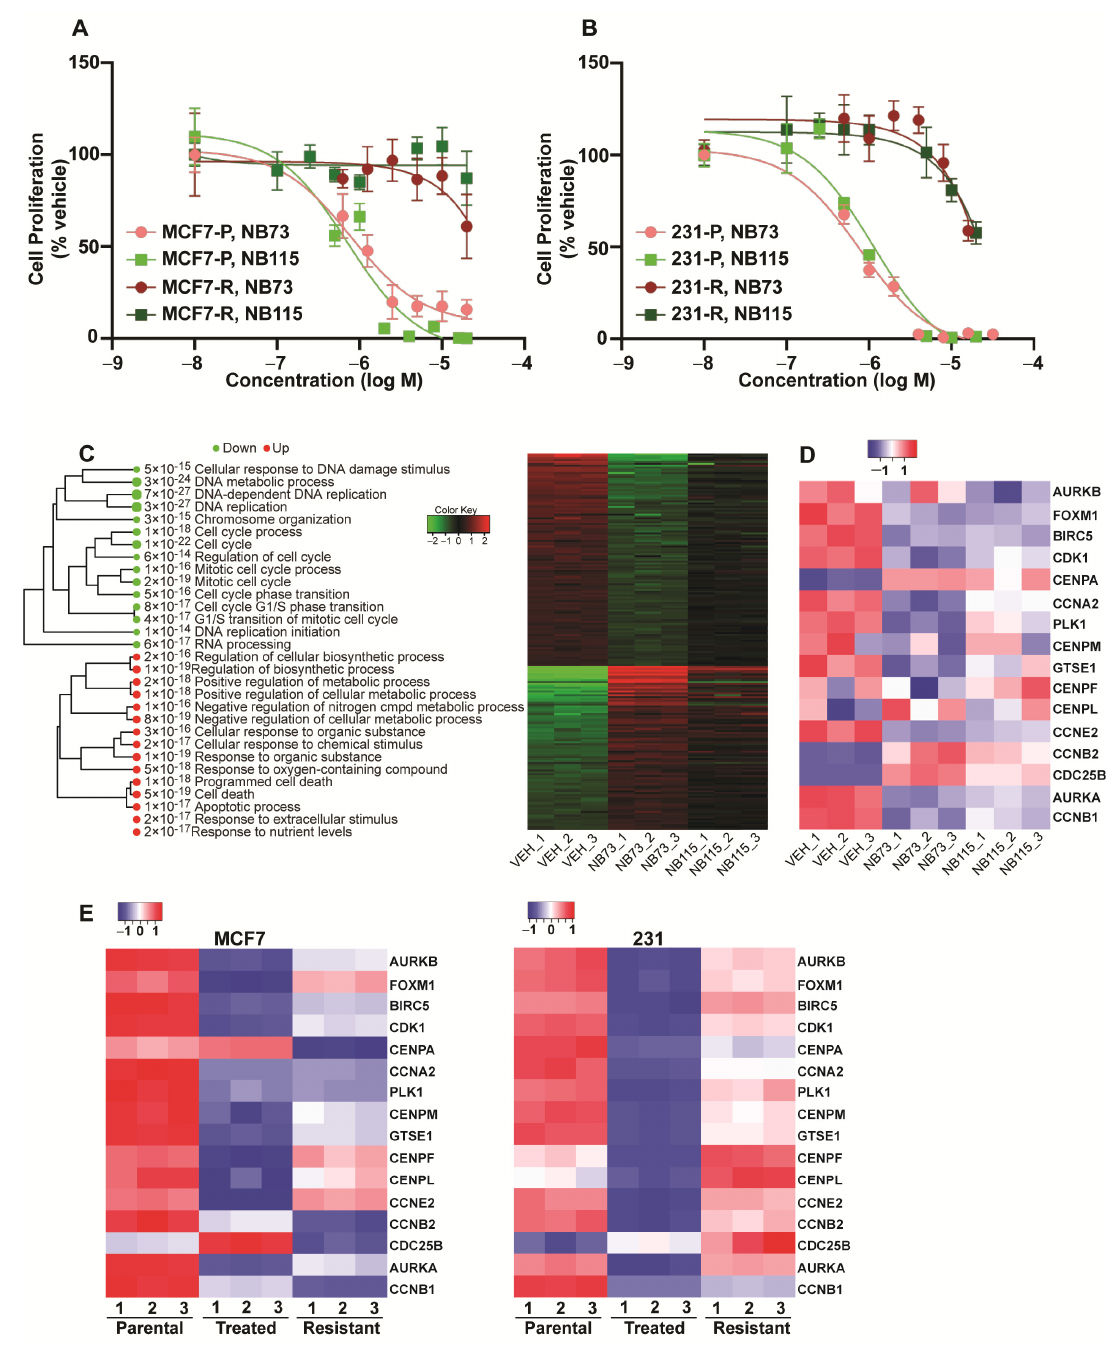
Figure 1. Effects of FOXM1 inhibitors on the proliferation and gene expression profiles of parental MCF7 and MDA-MB-231 cells and of cells grown long-term (>6 months) in the presence of inhibitors that acquired resistance to growth suppression. ( A , B ) Proliferation of parental (P) and resistant (R) cells was monitored after treatment for 5 days with the indicated concentrations of compounds NB73 or NB115. Assays were conducted in triplicate. Values are mean ± SEM. ( C ) Heatmap of differential RNA-seq gene expression analysis showing genes that were upregulated or downregulated >2-fold and with FDR < 0.05 in the treated groups (4 µ M NB73, 4 µ M NB115, MCF7 cells for 9 h) compared to Vehicle (n = 3 samples per group). Enrichment tree denotes GO terms associated with genes that were upregulated (red circles) and downregulated (green circles). Size of circles denotes magnitude of GO term p value. ( D ) Expression of FOXM1 target genes in parental vehicle treated MCF7 cells and in MCF7 cells treated with NB73 or NB115 for 9 h. Heat map shows 3 samples per group. ( E ) Regulation of FOXM1 signature genes is lost for most genes in the resistant cells. Expression of FOXM1 signature genes is shown in control MCF7 and 231 parental cells (P), in cells treated with NB73 for 24 h (T), and in resistant cells (R) maintained in 10 µM NB73 (n = 3).